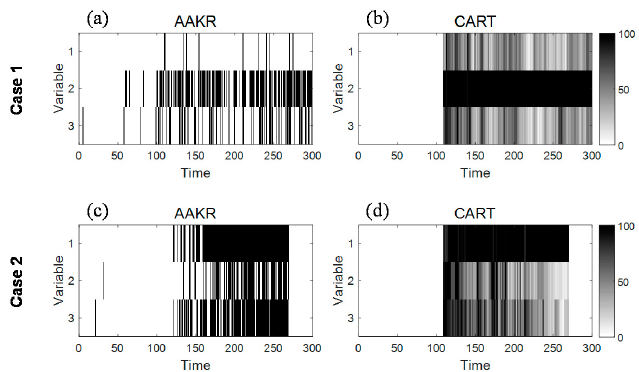
Figure 4. (Nonlinear process) Fault isolation results of AAKR-based contribution analysis and Method 2: ( a ) (Case 1) AAKR-based contribution plot; ( b ) (Case 1) variable importance values with Method 2;